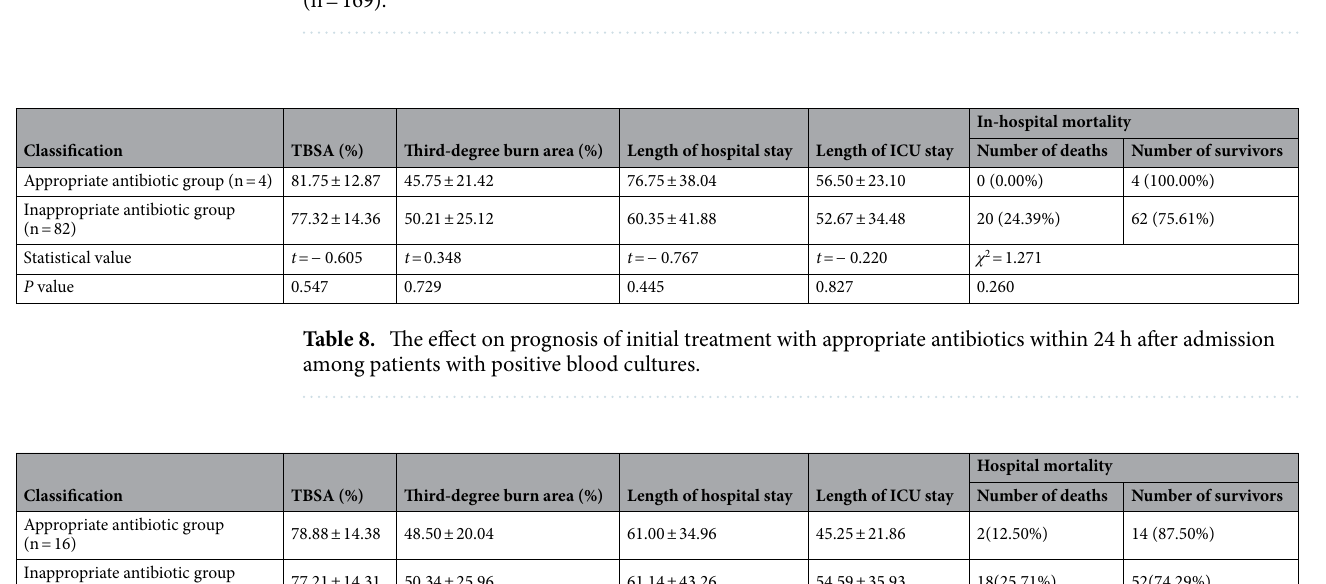
Table 7. Comparison of clinical characteristics between the lincomycin group and the carbapenem group (n = 169).